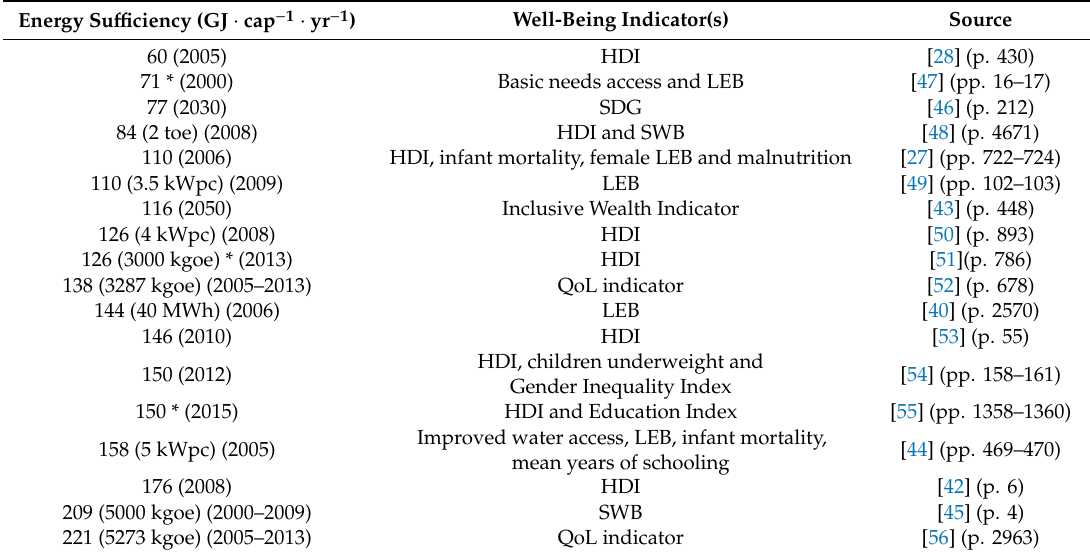
Table 1. Energy su ffi ciency values (lowest to highest) and well-being indicator(s) per